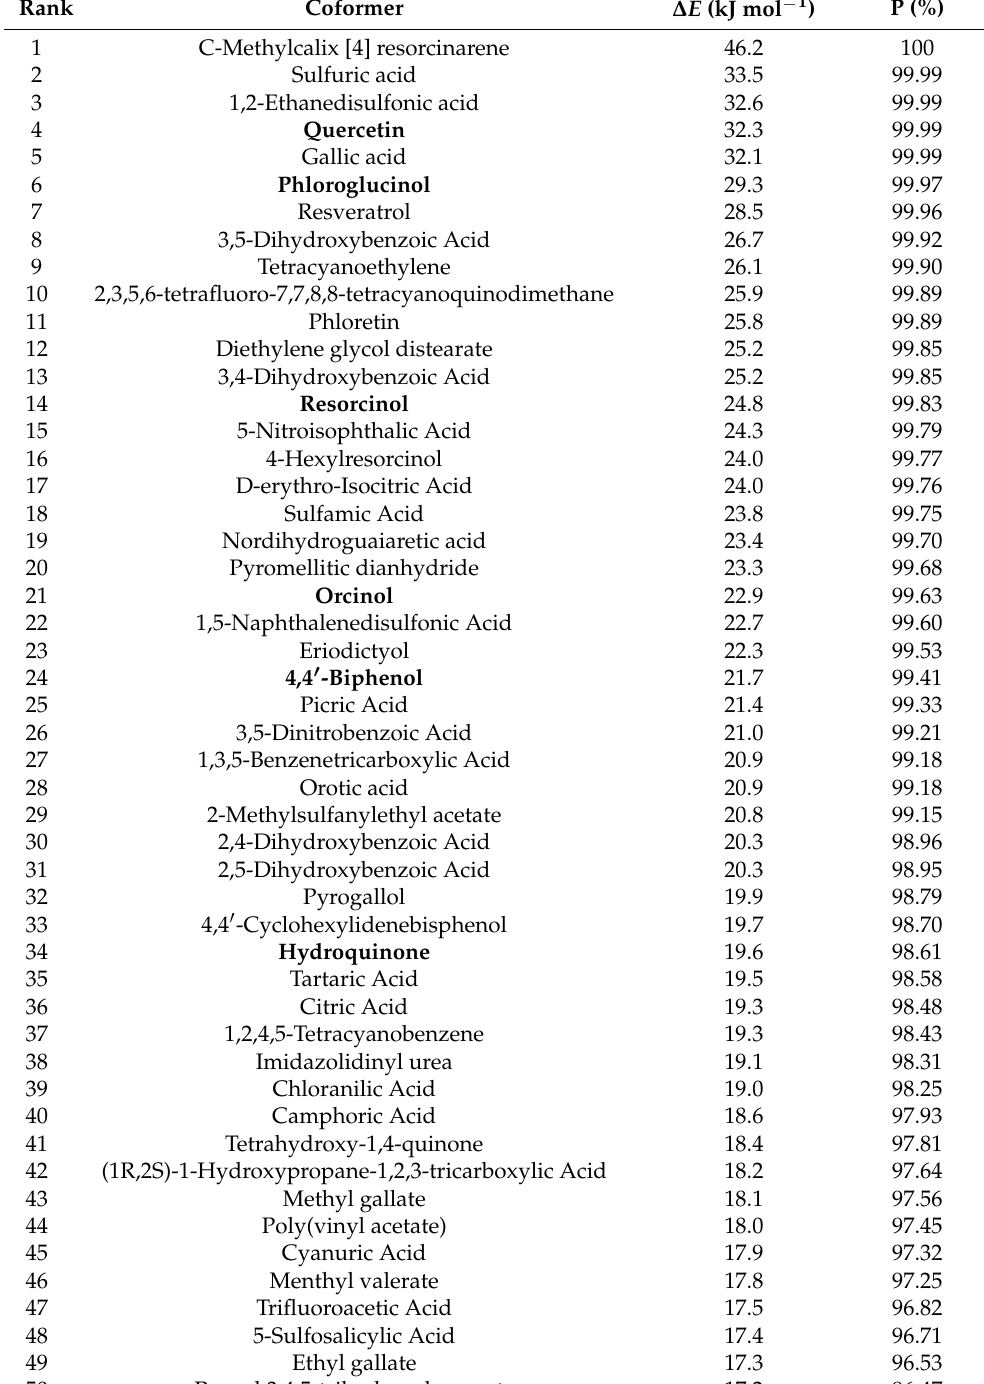
Table 1. Coformers ranked based on ∆ E and the probability of cocrystal formation with AD. Rank